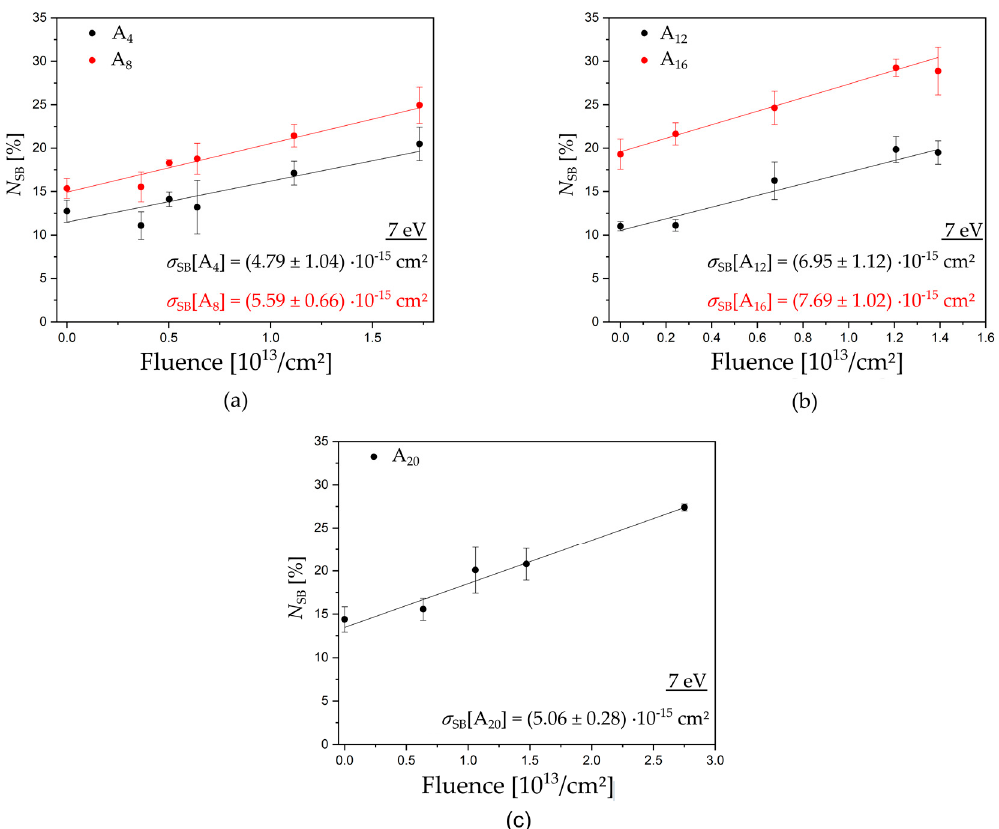
Figure 2. Examples of exposure response curves to determine the absolute DNA strand break cross